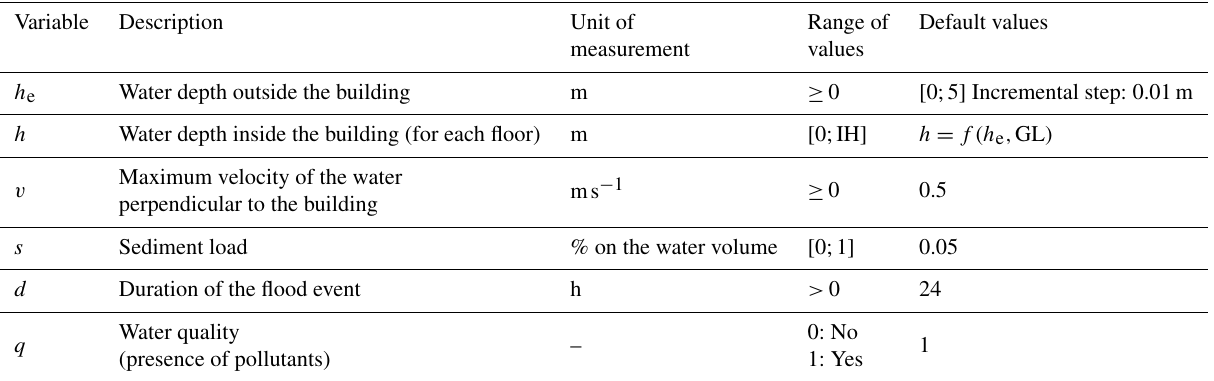
Table 2. Event features parameters considered in INSYDE.